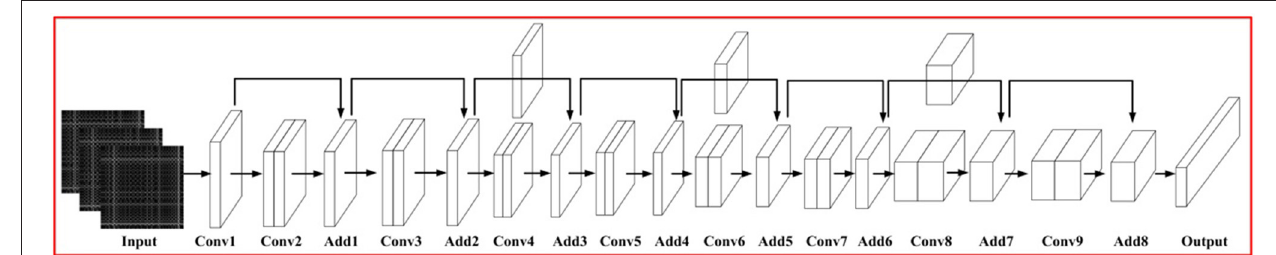
FIGURE 4 | Network structure.